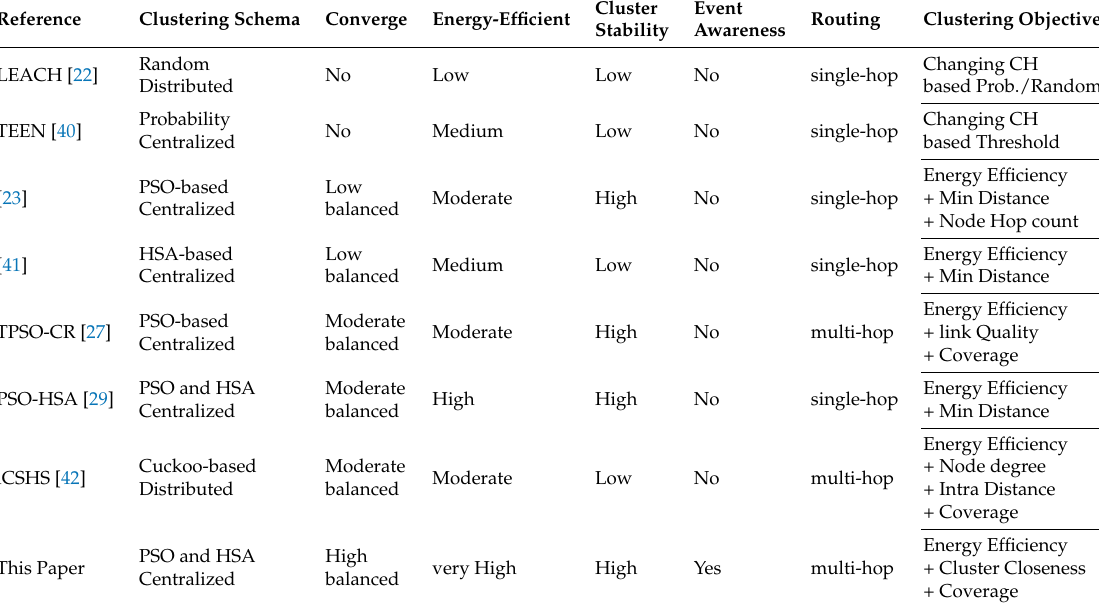
Table 1. Comparing different clustering protocols in Wireless Sensor Networks (WSNs) with our proposed method. LEACH: low-energy adaptive clustering hierarchy; TEEN: threshold-sensitive energy efficient sensor network protocol; PSO: Particle Swarm Optimization; HSA: Harmony Search Algorithm; CH: cluster head. TPSO-CR: Two-tier PSO protocol for Clustering and Routing. iCSHS: Integrated Clustering for Cuckoo Search and Harmony